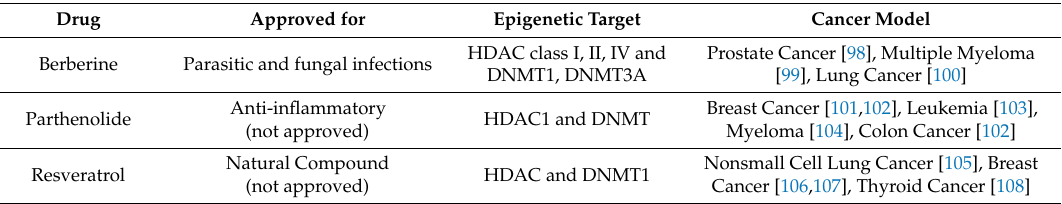
Table 4. Noncancer drug repurposing candidates for dual inhibition of DNMT and HDAC.